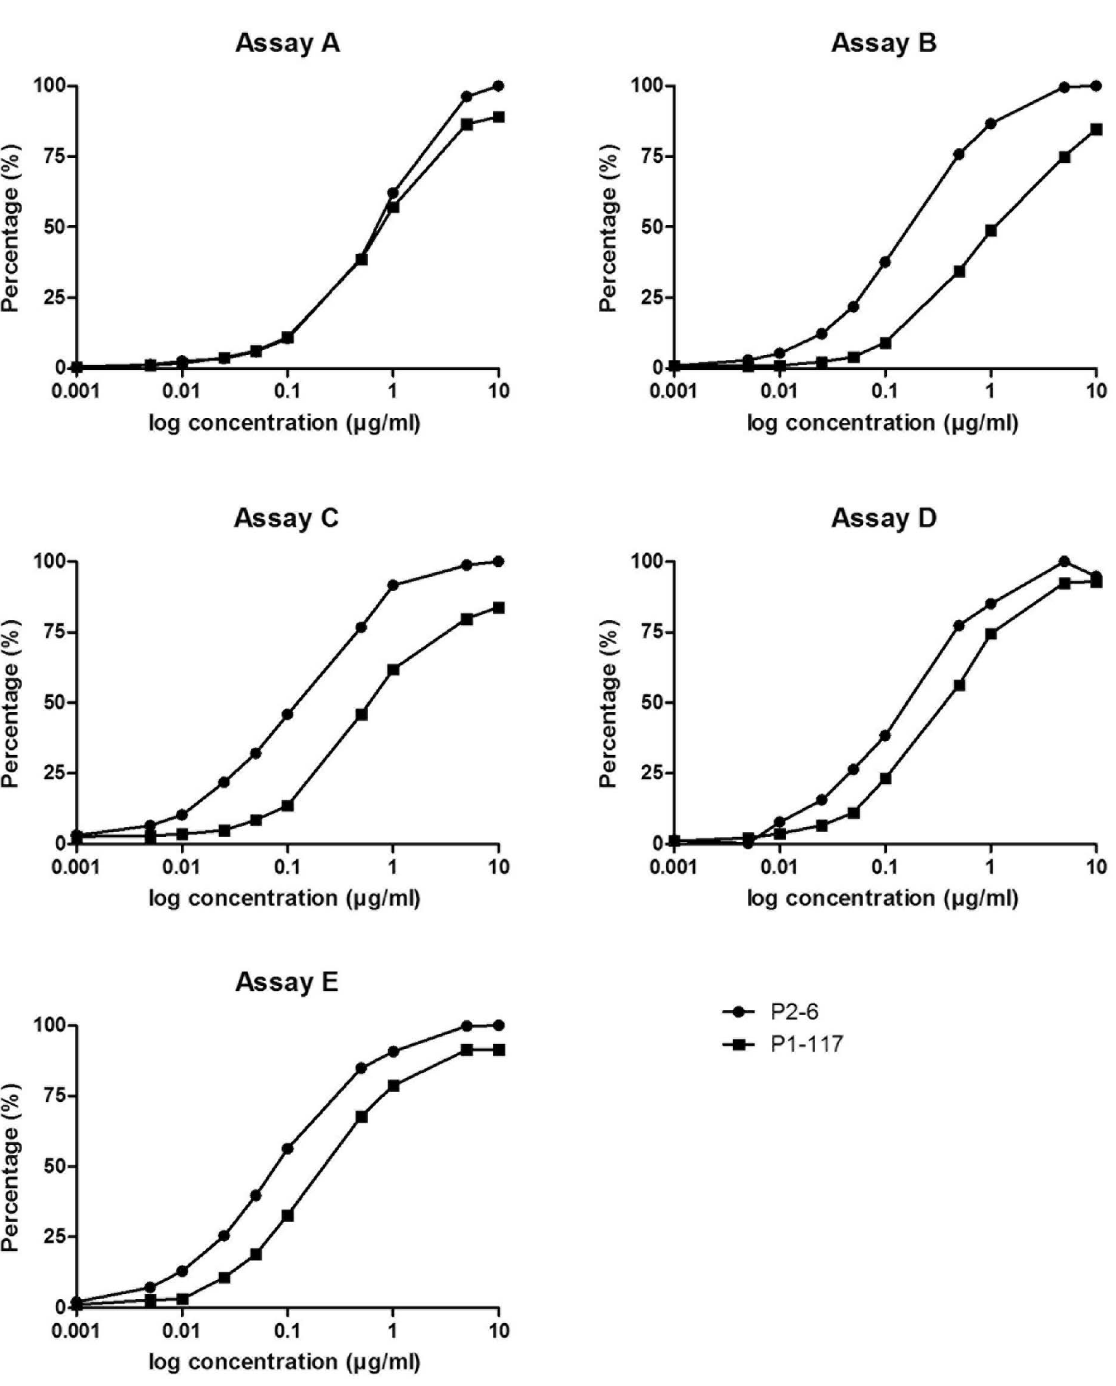
Figure 2. Comparison of the exposure of a domain I epitope G40-R43 of b 2 GPI in commercial anti- b 2 GPI IgG assays. Increasing concentrations, ranging from 0.001 to 10 m g/ml, from the monoclonal antibodies P1-117 and P2-6 are tested in 5 different anti- b 2 GPI assays, as described in Materials and Methods. Results are expressed as the percentage of the maximum OD value of P2-6. Based on the difference in reactivity of P2-6 and P1-117, assays can be evaluated. Results are representative for one out of 2 experiments.